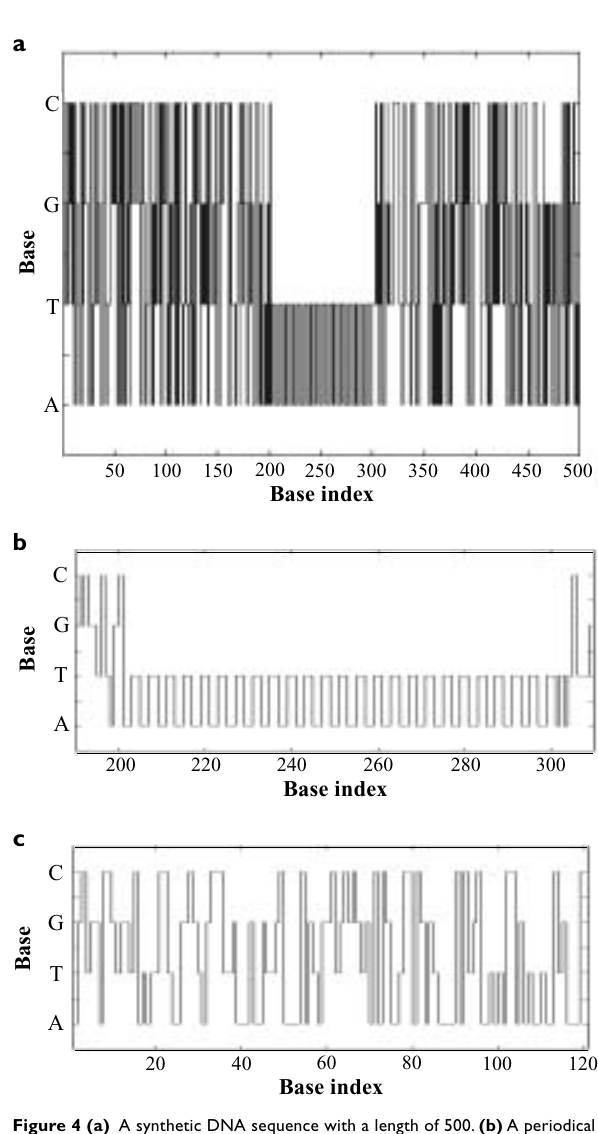
Figure 4 (a) A synthetic DNA sequence with a length of 500. (b) A periodical structure with a period-4 pattern of ‘AATTAATT… ’ lies at the middle region from base index 201 to 300. Left and right regions are with randomly generated bases. (c) Part of the left